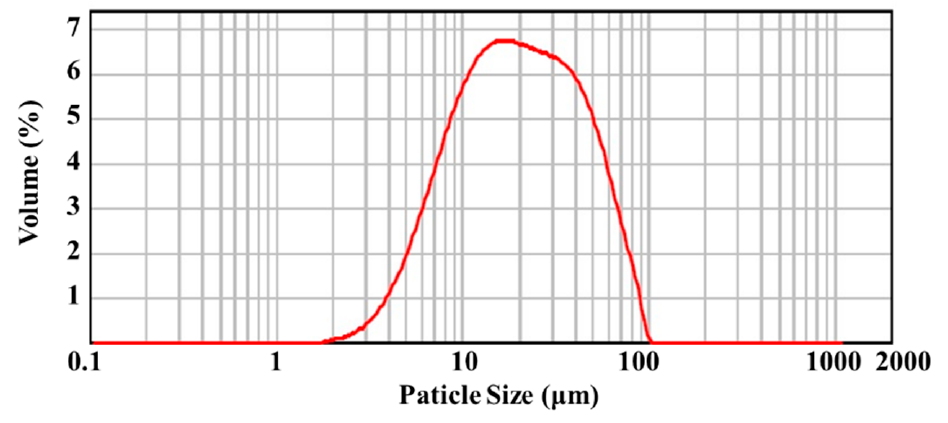
Figure 1. Particle size distribution of the gas-atomized Cu-10Sn powders used in the experiments.